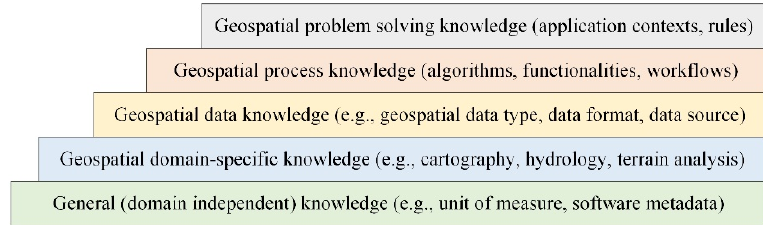
Figure 6. Knowledge required for the semantic description of parameter constraints.